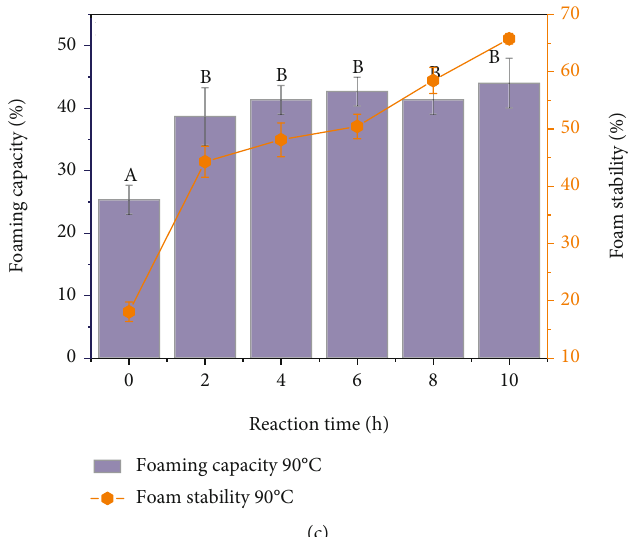
Figure 6: Foaming capacity and foam stability of BSFL-Glu conjugates as function of reaction time: (a) 50 ° C, (b) 70 ° C, and (c) 90 ° C. Values are mean ± standard deviation ; means with di ff erent superscripts are signi fi cantly di ff erent at the same heating